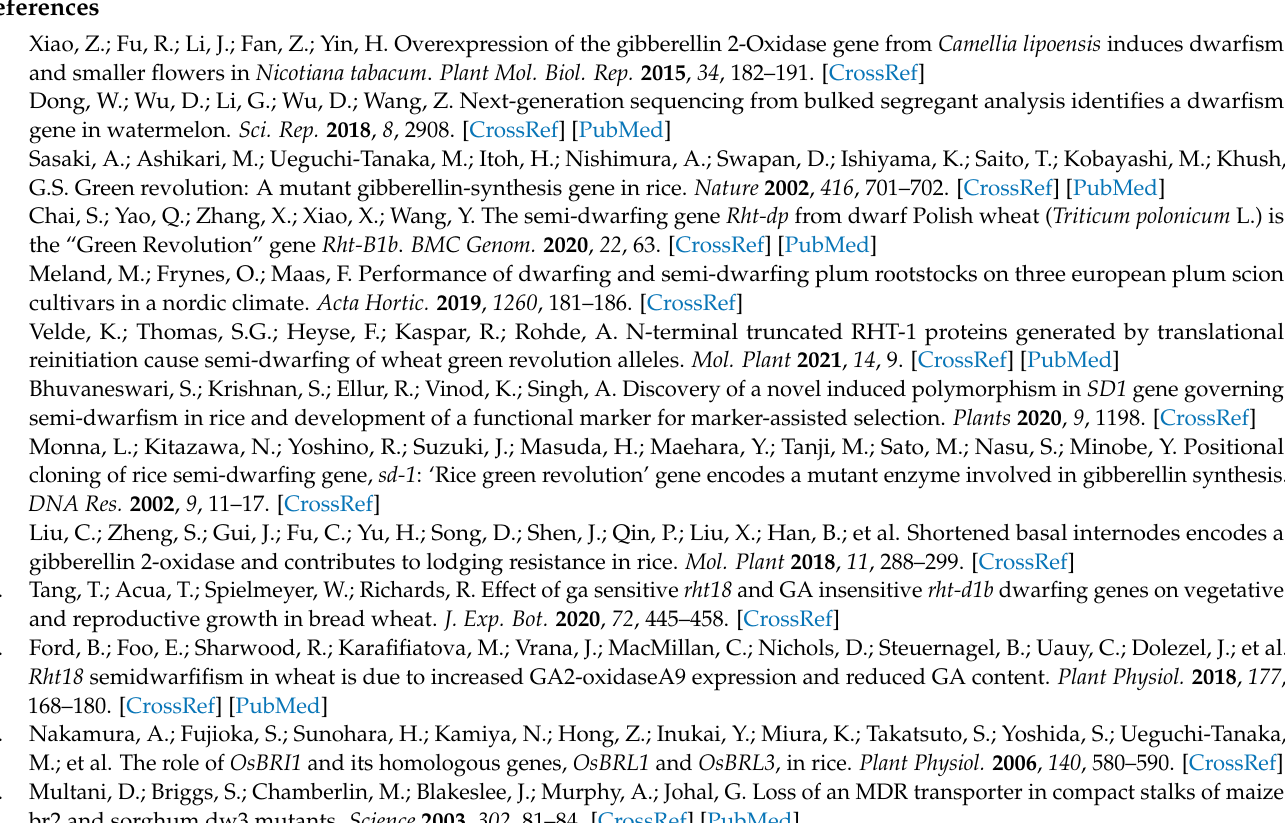
Table S2: Morphological characterization of Si1 and WT N87; Table S3: Genes annotated in the mapping